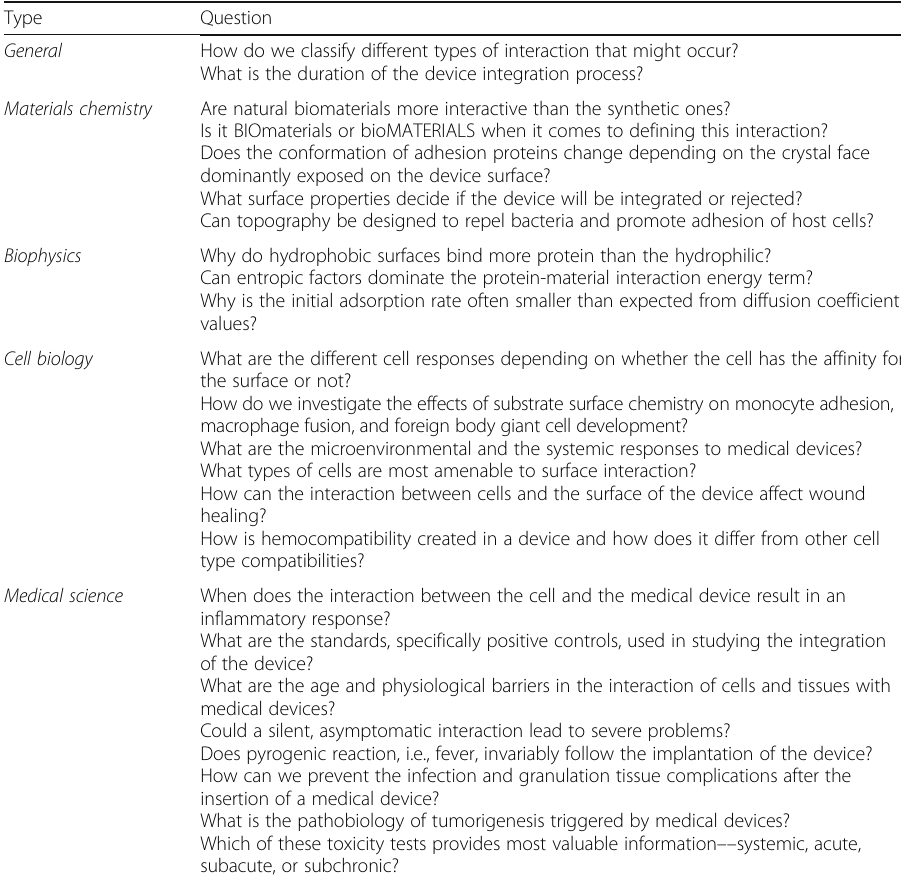
Table 1 Questions compiled during an in-class polling session on the topic of interaction between medical devices and biological systems and classified depending on the discipline